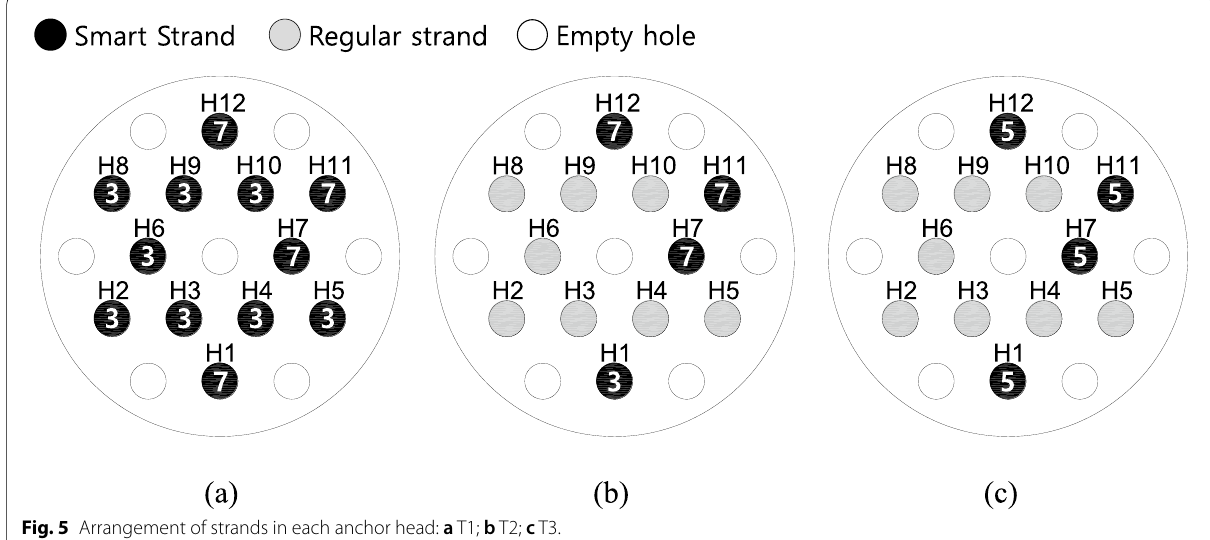
Fig. 5 Arrangement of strands in each anchor head: a T1; b T2; c T3.